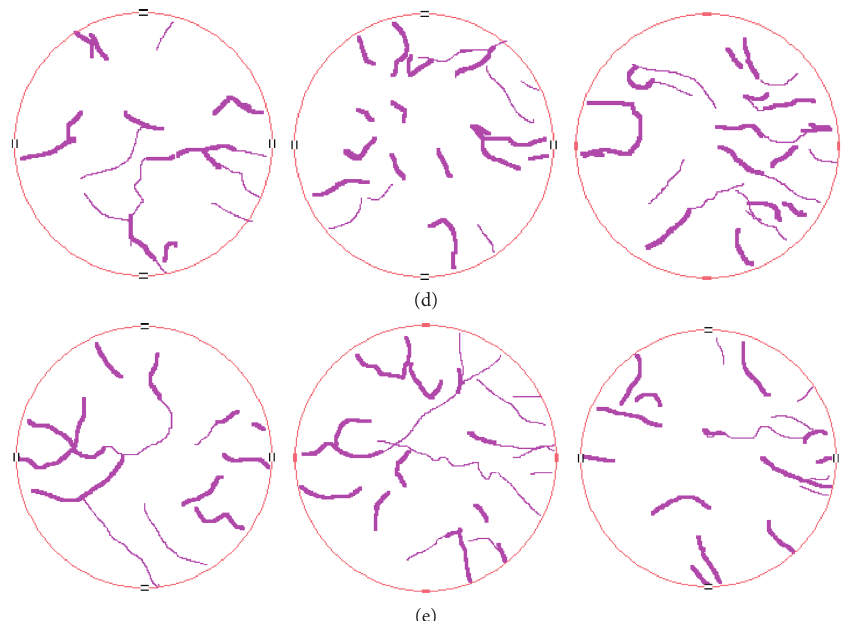
Figure 10: The cracks segmentation from the original CT slices at the five loading levels. (a) ε � 1.756%. (b) ε � 3.106%. (c) ε � 4.427%. (d) ε � 6.649%. (e) ε � 8.059%.